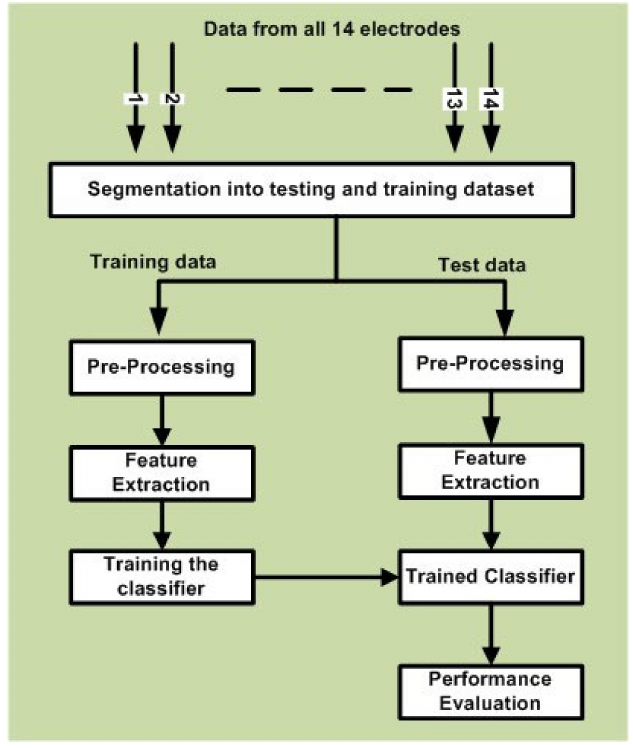
Figure 3. Block diagram explaining the data analysis